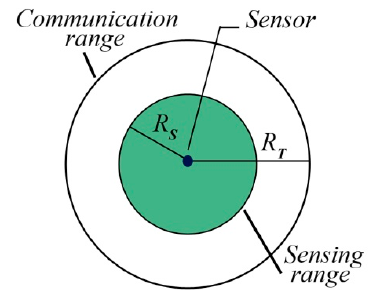
Figure 2. Perception model of sensor node.